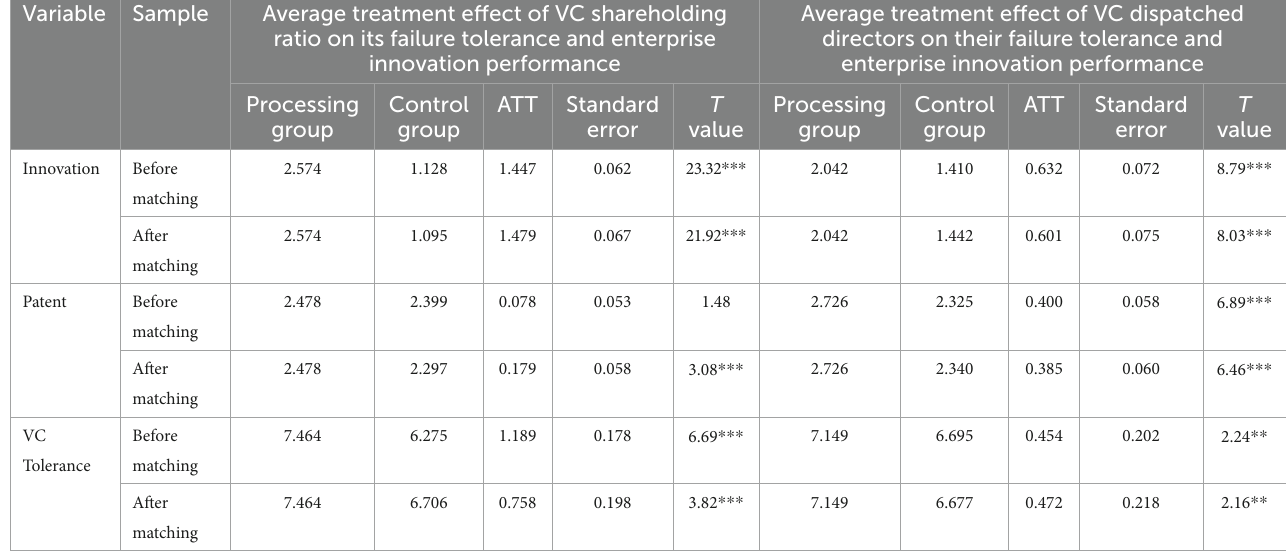
TABLE 10 Average treatment effect (ATT) of VC shareholding ratio, dispatched directors’ tolerance to failure, and enterprise innovation performance.